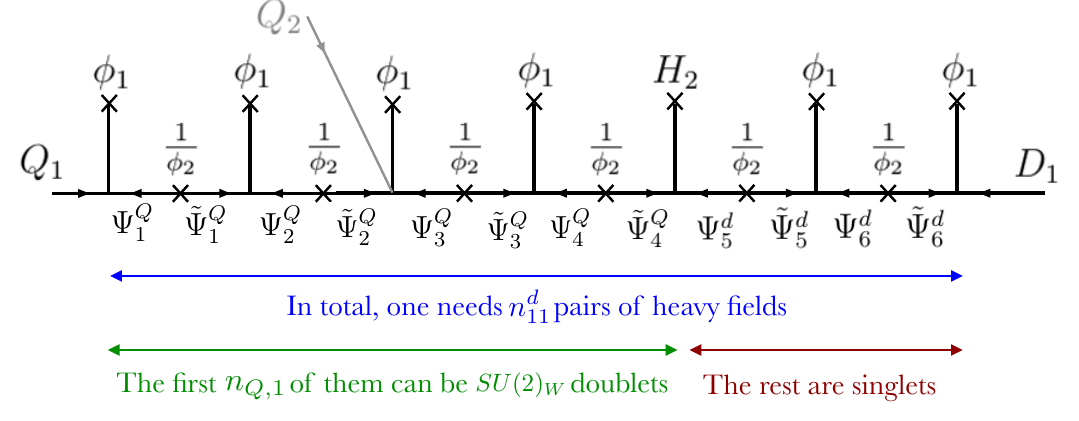
Figure 1 . Tree diagram generating the d -quark mass, when n d indicates how it should be modi(cid:12)ed to generate a mixing to Q 2 when n d